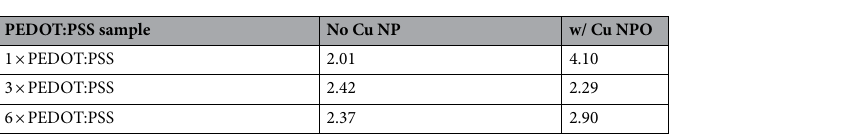
(d) 1 x PEDOT:PSS with Cu NP; sr rms = 4.10 nm (e) 3 x PEDOT:PSS with Cu NP; sr rms = 2.29 nm (f) 6 xPEDO T:PSS no Cu NP; sr rms = 2.90 nm Figure 7. AFM pictures of PEDOT:PSS of a single, triple, and sixfold coatings of PEDOT:PSS with and without Cu NP. The scanned area of all the plots is 500 nm × 500 nm. The root mean square surface roughness, sr rms , is also indicated for the respective surface surface. ( a ) a single PEDOT:PSS no Cu NP; sr rms = 2.01 nm, ( b ) a triple PEDOT:PSS no Cu NP; sr rms = 2.42 nm, ( c ) a sixfold PEDOT:PSS no Cu NP; sr rms = 2.37 nm, ( d ) a single PEDOT:PSS with Cu NP; sr rms = 4.10 nm ( e ) a triple PEDOT:PSS with Cu NP; sr rms = 2.29 nm, ( f ) a sixfold PEDOT:PSS with Cu NP; sr rms = 2.90 nm. PEDOT:PSS